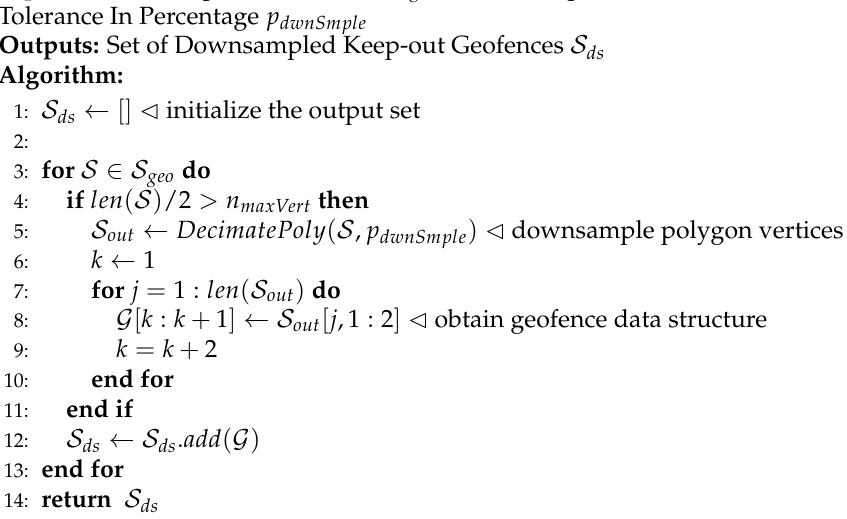
Algorithm 2 Reduce Map Geofence Vertex Set.